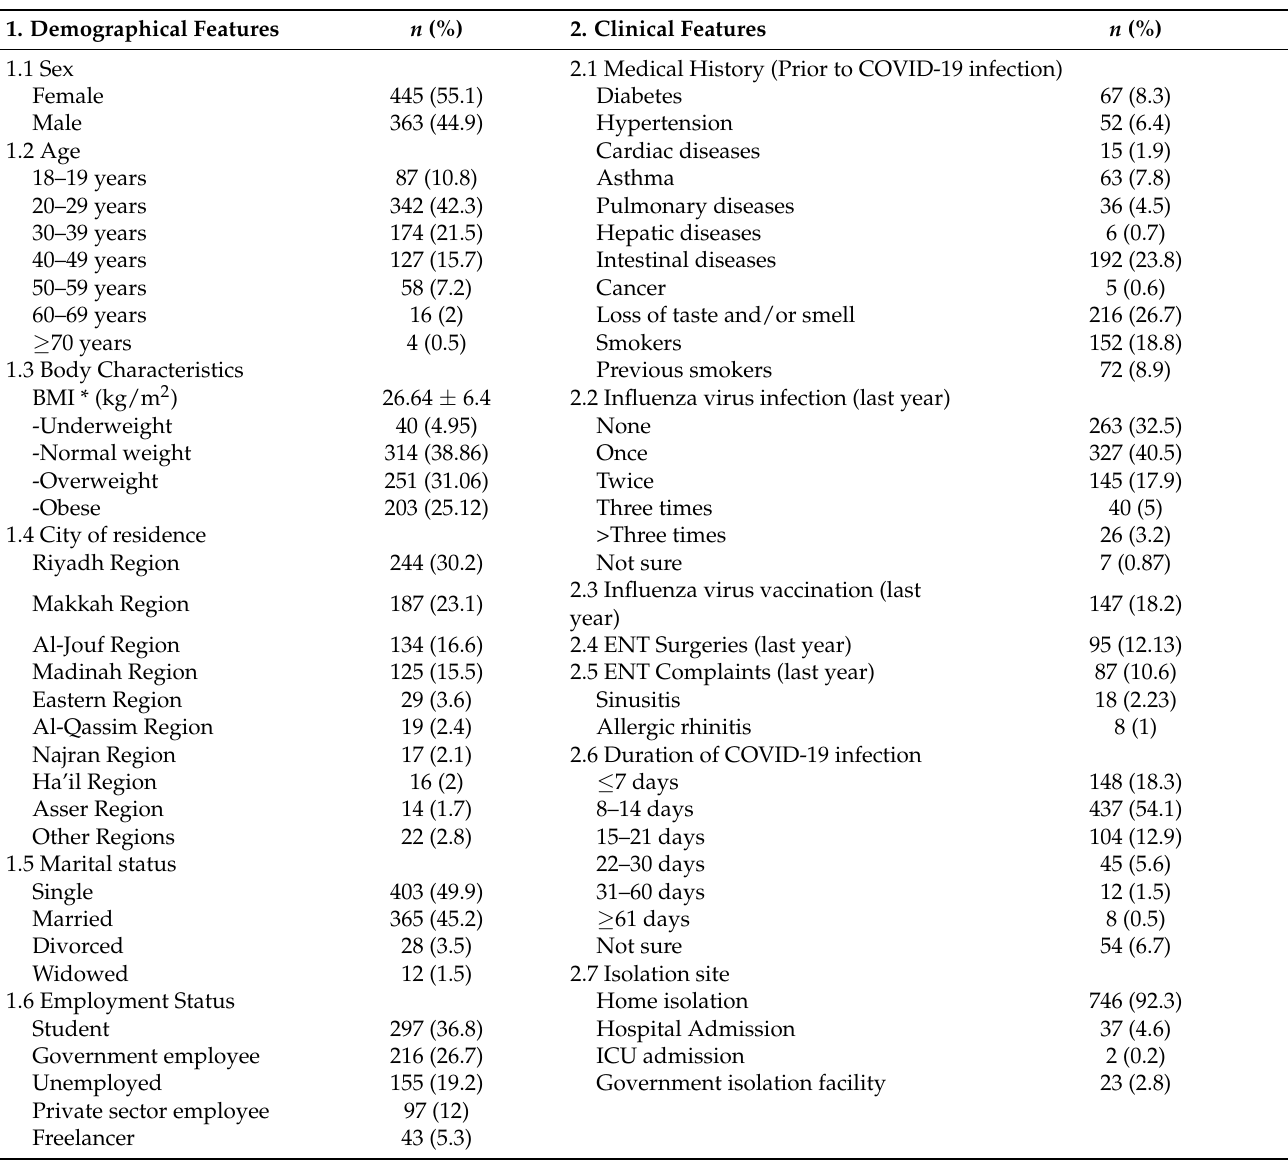
Table 1. Clinical and demographical features of COVID-19